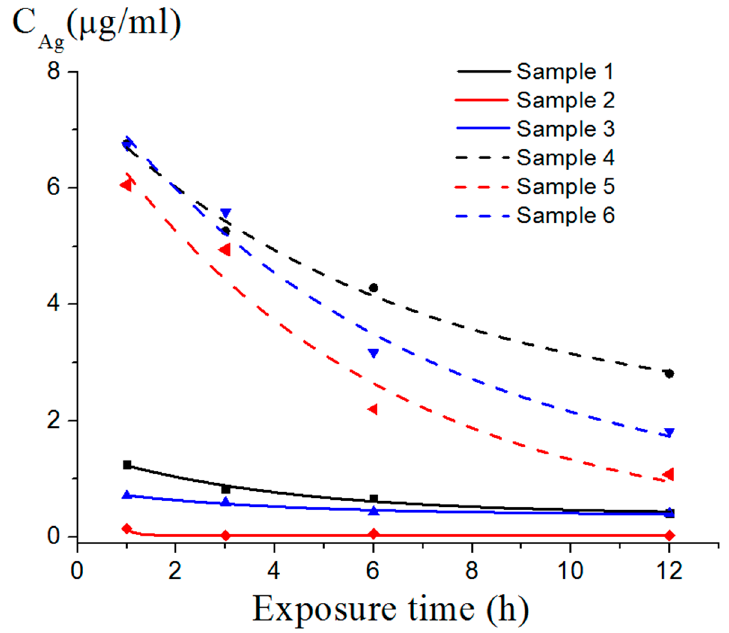
Figure 16. Kinetic curves of silver ion migration.